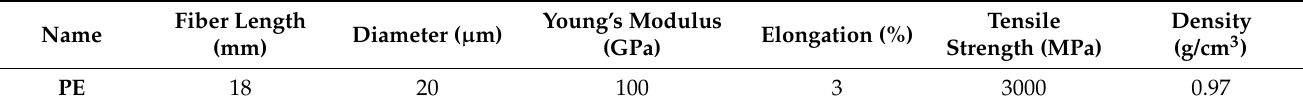
Table 3. Properties of PE